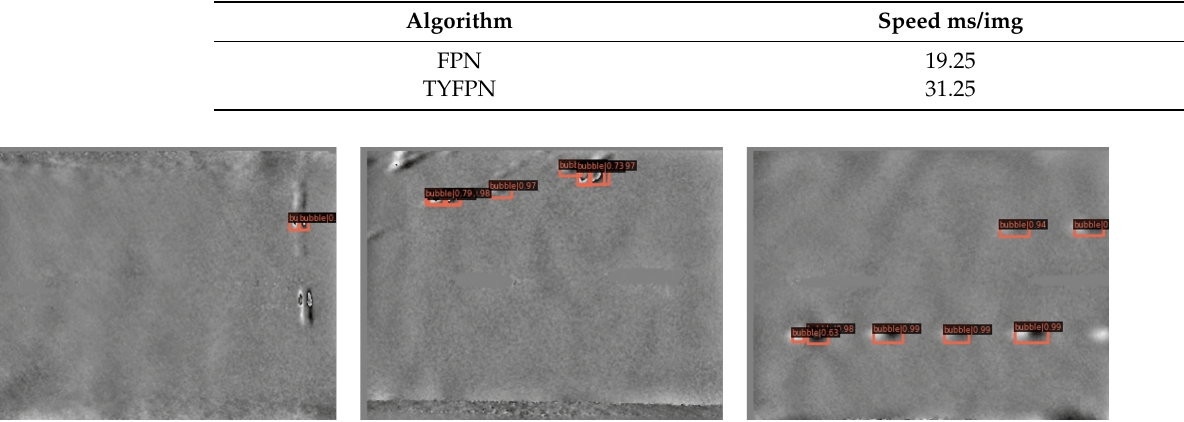
Table 6. The speed of detection by different methods.